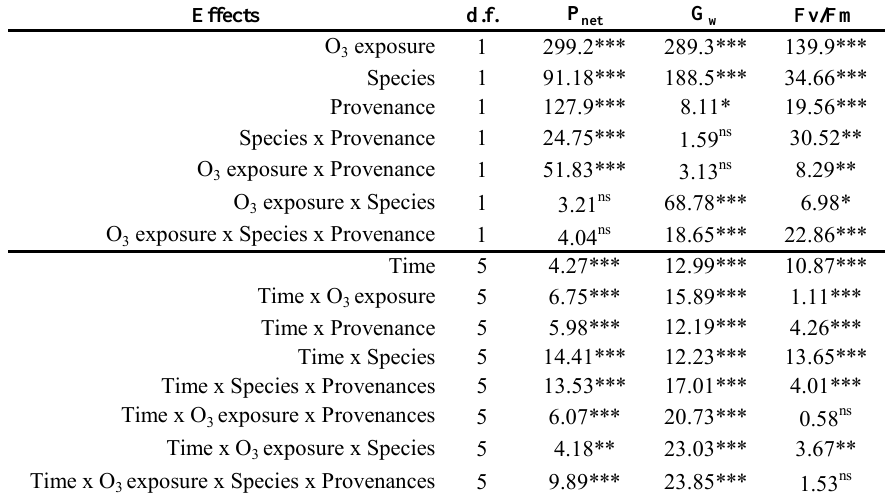
F Values of Three-Way Repeated ANOVA of the Effects of O (0 and 150 nmol mol –1 , 8 h day –1 ), Species ( F. excelsior and F. ornus ), and Provenance (Piedmont and Tuscany) with Time as Repeated-Measure Factor (0, 7, 14, 21, 28, and 35 Days of Exposure) Effects